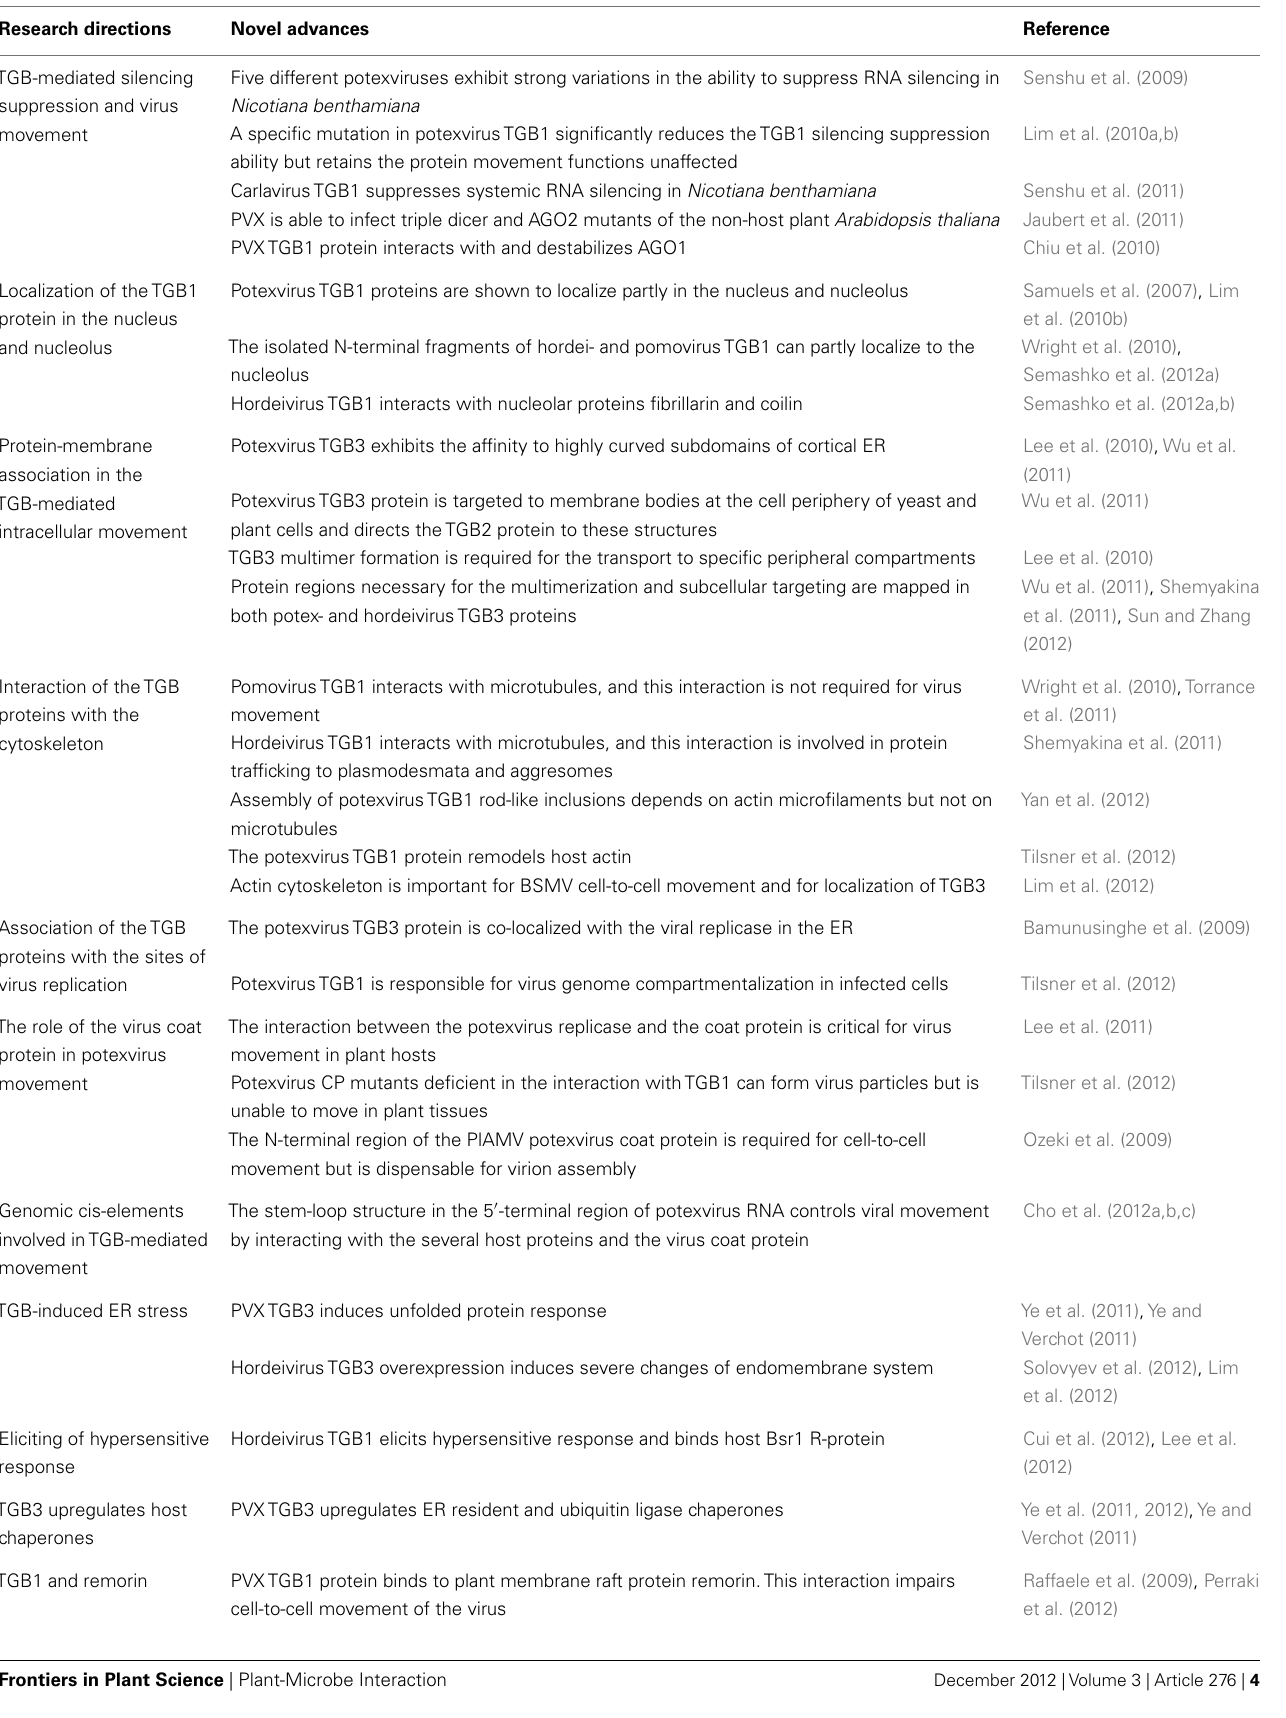
Table 1 | Overview of recent achievements in the cell biology studies